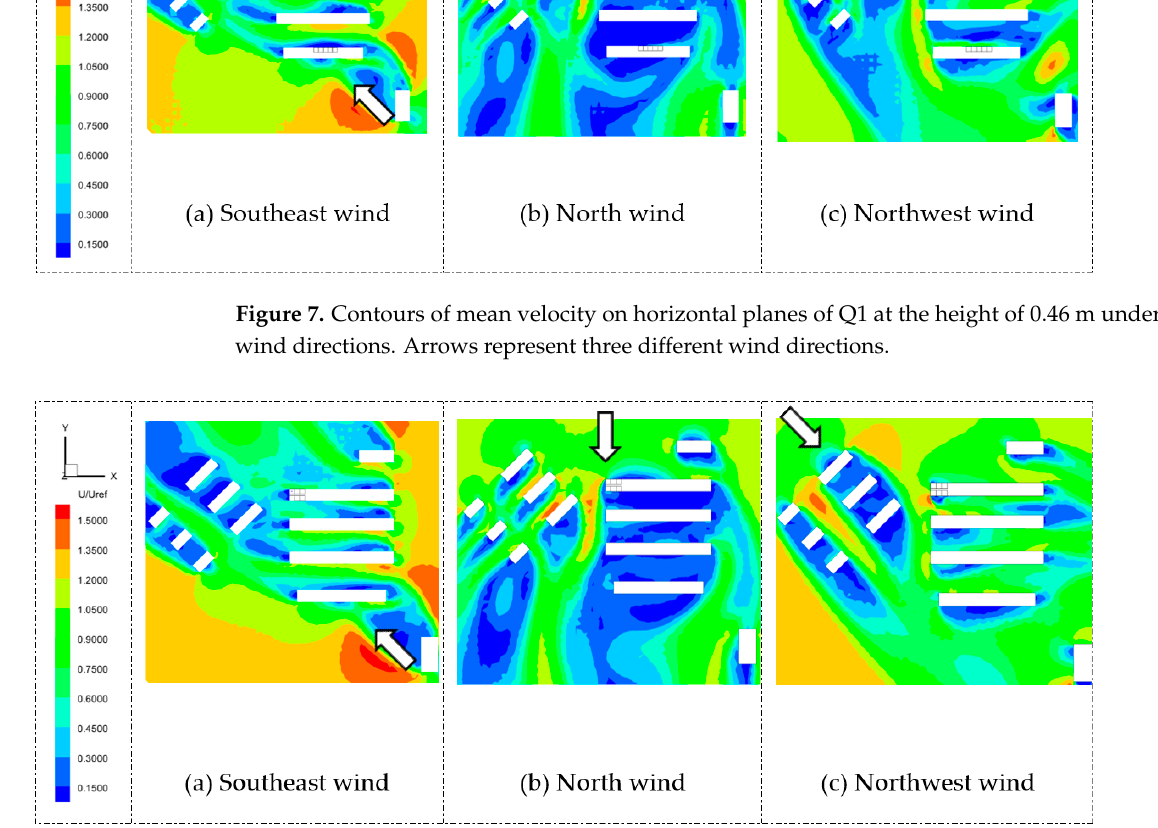
Figure 8. Contours of mean velocity on horizontal planes of D3 at the height of 0.76 m under three wind directions. Arrows represent three different wind directions.